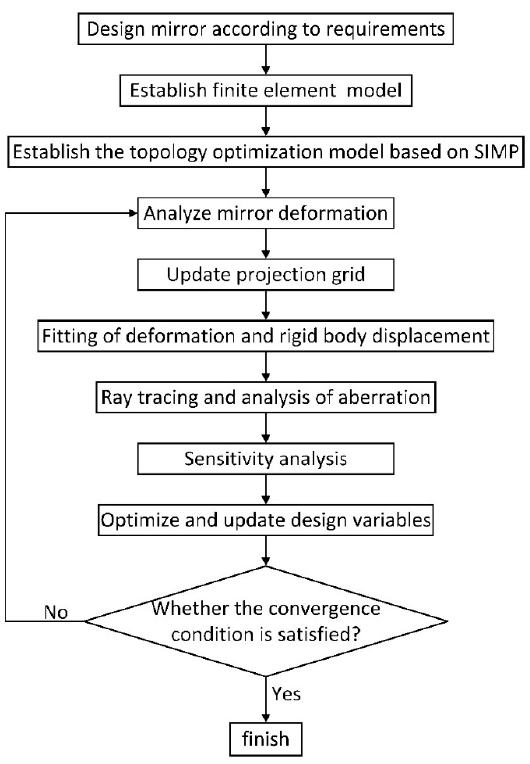
Figure 3. Flow chart of optical–mechanical coupling topology optimization.